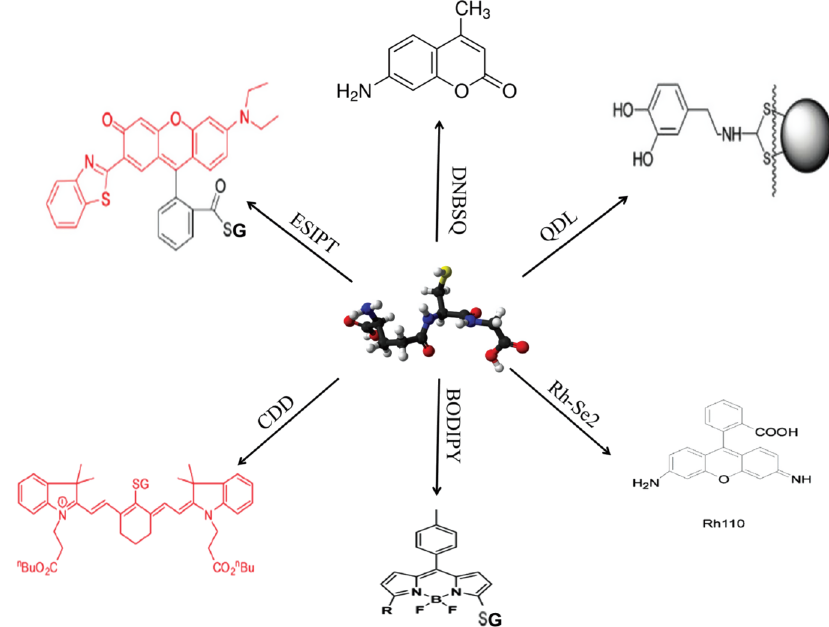
Figure 2: Chemical derivatization reactions used for spectroscopic detection of